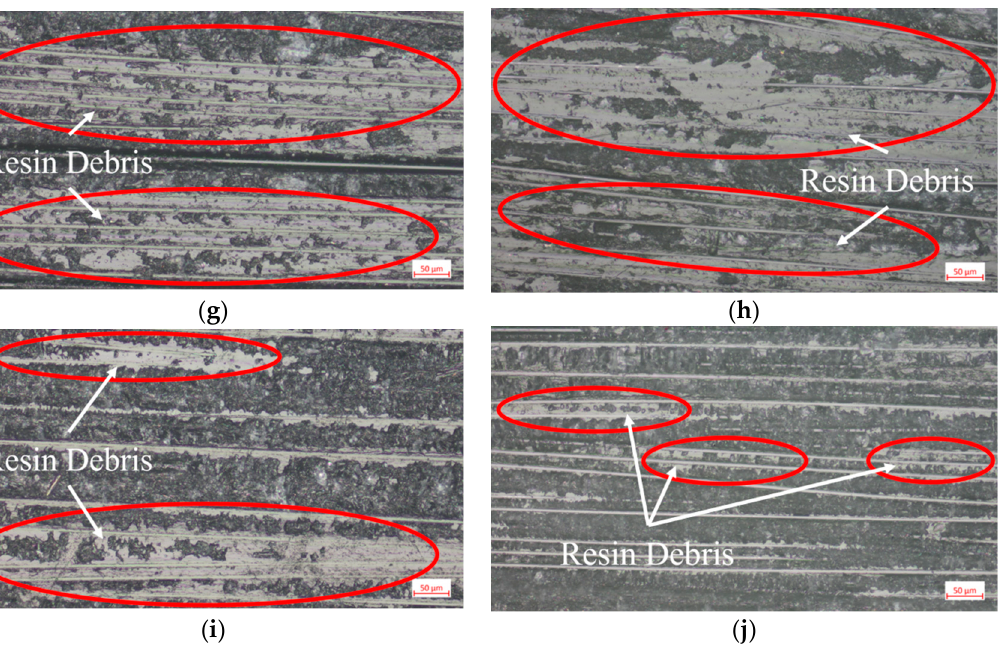
Figure 7. Micrographs of the failure surfaces of the tensile shear specimen with different times of flame treatment: ( a ) GF/EP infusion sheets that have not undergone flame treatment; ( b ) GF/EP pultruded sheet that has not undergone flame treatment; ( c ) GF/EP infusion sheet with one flame treatment; ( d ) GF/EP pultruded sheet after one flame treatment; ( e ) GF/EP infusion sheet after three flame treatments; ( f ) GF/EP pultruded sheet after three flame treatments; ( g ) GF/EP infusion sheet after five flame treatments; ( h ) GF/EP pultruded sheet after five flame treatments; ( i ) GF/EP infusion sheet after seven flame treatments; ( j ) GF/EP pultruded sheet after seven flame treatments.